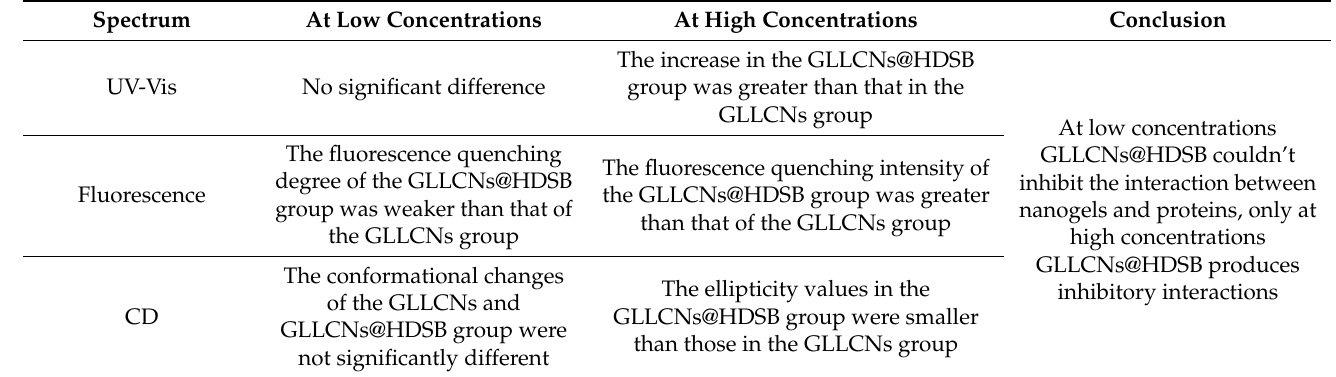
Figure 4. ( A , B ) CD spectra of BSA incubated with GLLCNs ( A ) and GLLCNs@HDSB ( B ) at different concentrations. ( C ) The CD ellipticity values at 208 nm of different particles. ( D ) The ellipticity values in increasing increments of GLLCNs and GLLCNs@HDSB. Table 3. The results of the investigation upon GLLCNs and